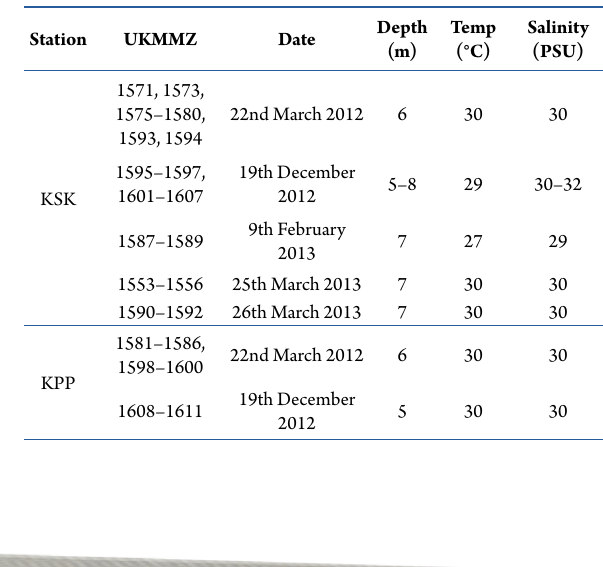
Table 1. Coding and field parameters of each examined